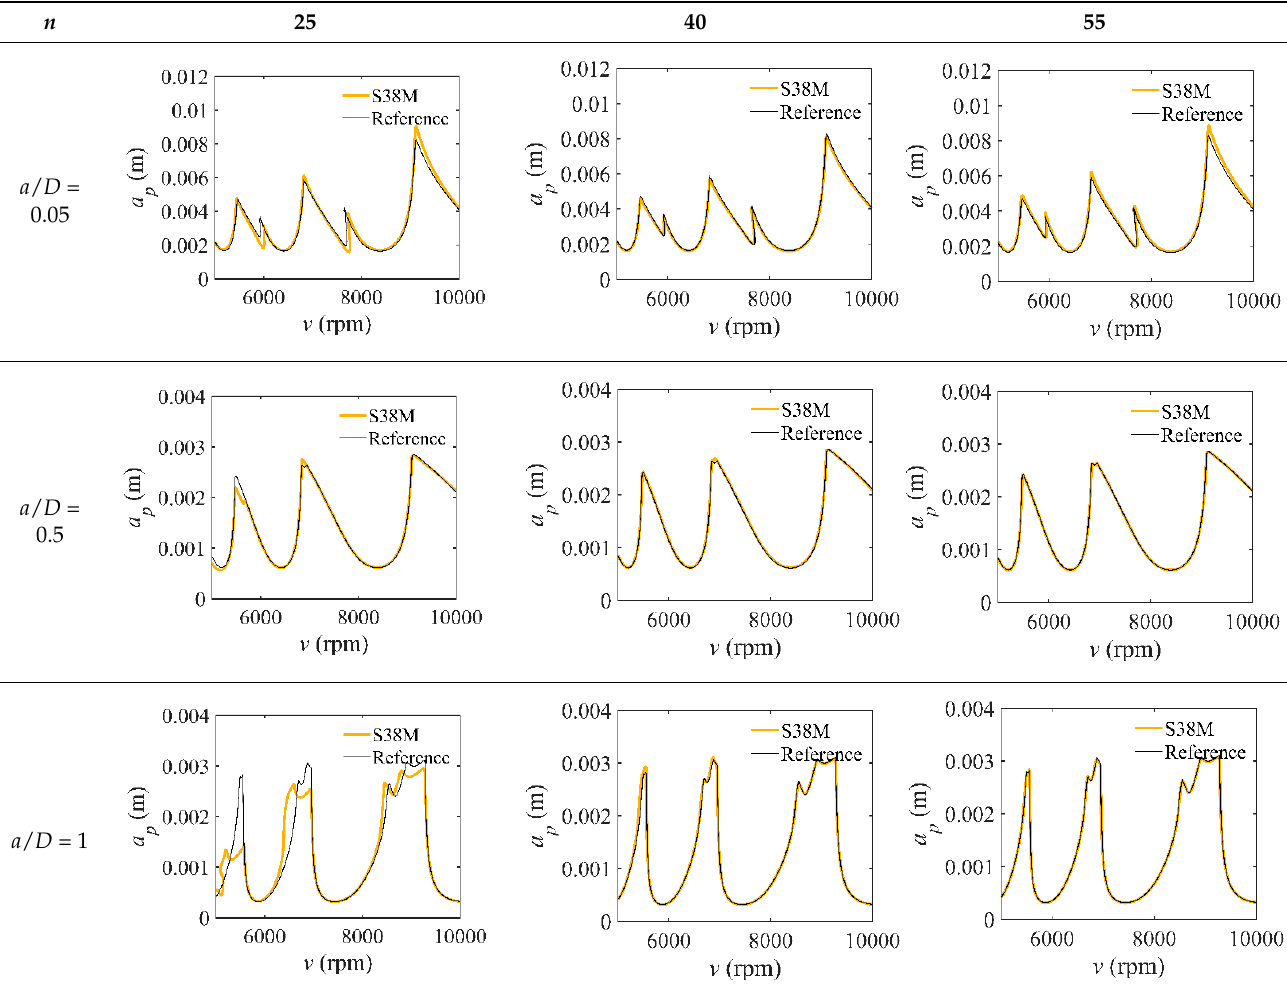
Figure 9. Convergence rate comparisons of the S38M, CCM, SDM, and SEM when and a / D = 0.05. ( a ) a p = 0.0001 m; ( b ) a p = 0.0002 m; ( c ) a p = 0.0003 m.